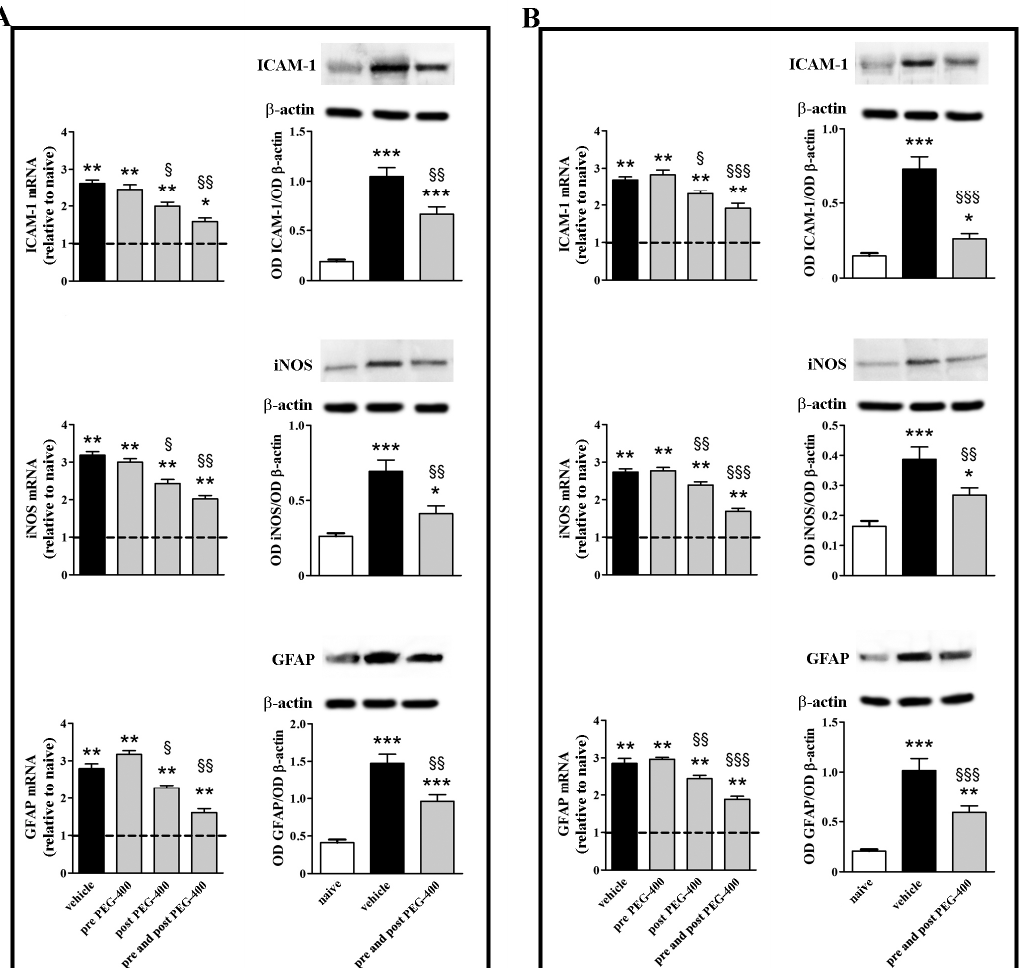
Figure 3. mFAG dietary supplementation reduces PEG-400-induced upregulation of markers of inflammation in the retina ( A ) or in the RPE/choroid ( B ). Levels were evaluated in mice untreated or subretinally injected with 0.5 mg PEG-400 and receiving vehicle or mFAG for 10 days before PEG-400 injection (pre-PEG-400), for five days after PEG-400 injection (post-PEG-400), or for 10 days before and five days after PEG-400 injection (pre- and post-PEG-400). Transcripts were evaluated by relative quantification with qPCR. Data were analyzed by the formula 2 −ΔΔ CT using Rpl13a as the internal standard. Proteins were evaluated by Western blot using β -actin as loading control. Data were presented as the mean ± S.E.M. ( n = 6/group). * p < 0.05, ** p < 0.01 and *** p < 0.001 versus naive; § p < 0.05, §§ p < 0.01 and §§§ p < 0.001 versus vehicle (one-way ANOVA followed by the Newman-Keuls multiple comparison post-hoc test). Dotted lines, mRNA levels in naive; white bars, naive; black bars, PEG-400-induced mice with vehicle dietary supplementation; grey bars, PEG-400-induced mice with mFAG dietary supplementation.